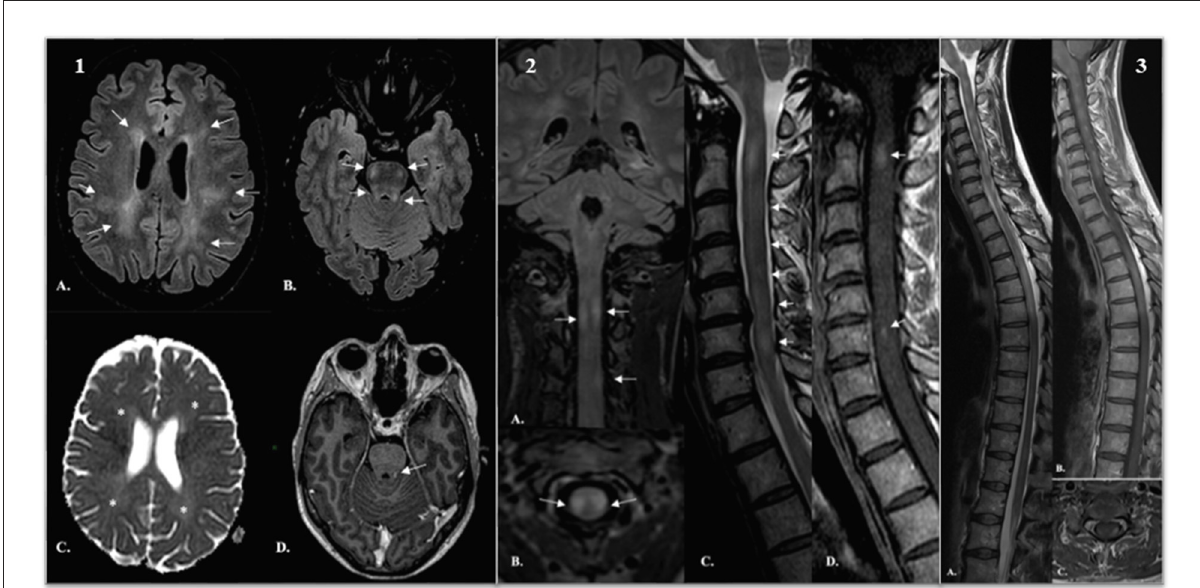
FIGURE1 Part 1: (A,B) Axial T2 FLAIR-weighted images demonstrated extensive, asymmetric involvement of periventricular and deep white matter [arrows in (A)]. Smaller lesions were observed in the ponto-mesencephalic tegmentum, superior and middle cerebellar peduncles [arrows in (B)]. (C) Lesions were mildly hyperintense on ADC cartography, revealing increased diffusivity (*). (D) A small focus of contrast enhancement was demonstrated in the left superior cerebellar peduncle (arrow). Part 2: (A–C) Reformatted coronal (A) and axial (B) T2 FLAIR-weighted images and sagittal T2-weighted images and sagittal T2 weighted image (C) reveal multiple short-segment hyperintensities (arrows). Lesions are asymmetric and excentrically located and involve both white and gray matter. Signal intensity is variable, from midly to markedly increased. (D) Sagittal post-gadolinium T1-weighted image shows scattered foci of enhancement (arrows). Part 3: (A–C) Sagittal T2 (A) and post-contrast sagittal (B) and axial (C) T1-weighted images demonstrate progression of disease. We found lesions on the entire spinal cord. FLAIR, fluid attenuated inversion recovery; ADC, apparent diffusion